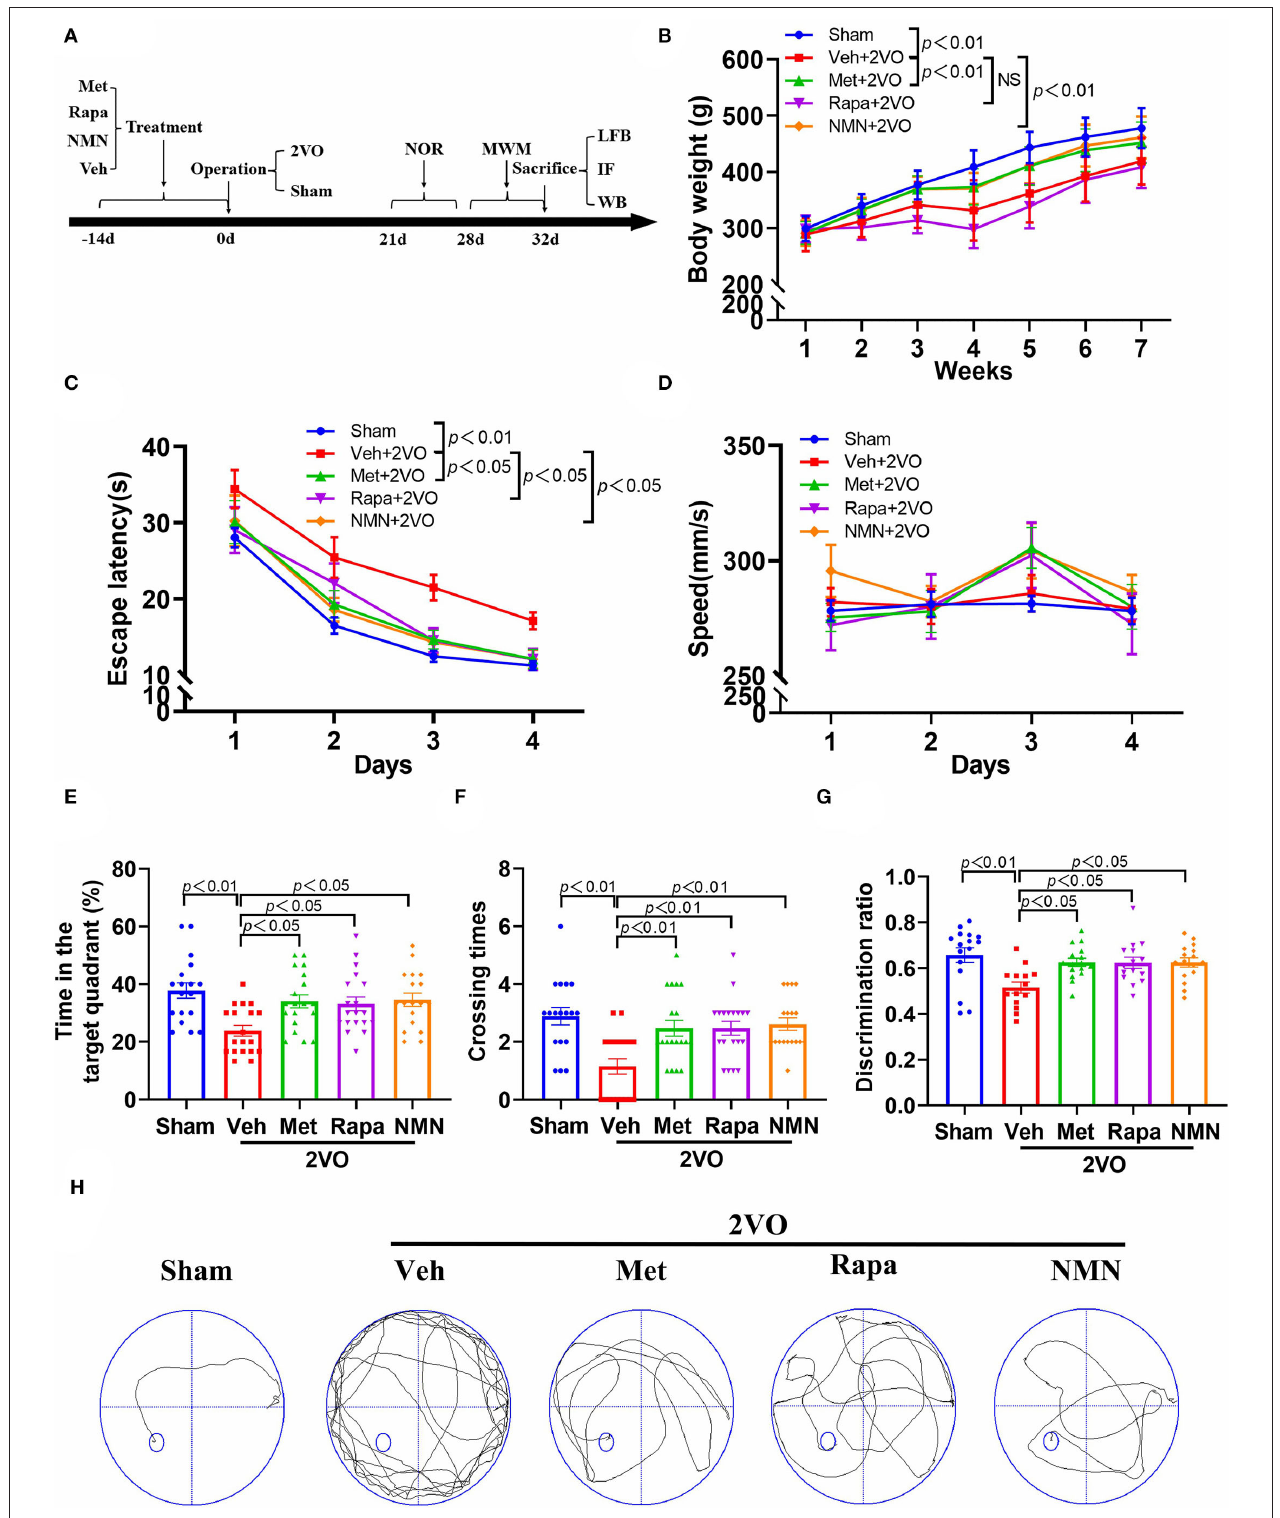
FIGURE 1 | Metformin, rapamycin, or NMN pretreatment improves cognitive impairment in BCCAO rats. (A) Experimental protocol. Rats received either saline (Veh), metformin (Met), rapamycin (Rapa), or NMN (NMN) at 2 weeks before surgery via intraperitoneal (i.p.) injection daily for 14 consecutive days. The animals were scarified 32 days after surgery. (B) The body weight of rats from different groups ( n = 20). The p -values were assessed by two-way repeated-measures ANOVA with Tukey’s post hoc test. The escape latency (C) and swimming speed (D) during the training phase, and duration in the target quadrant (E) , and the times crossing